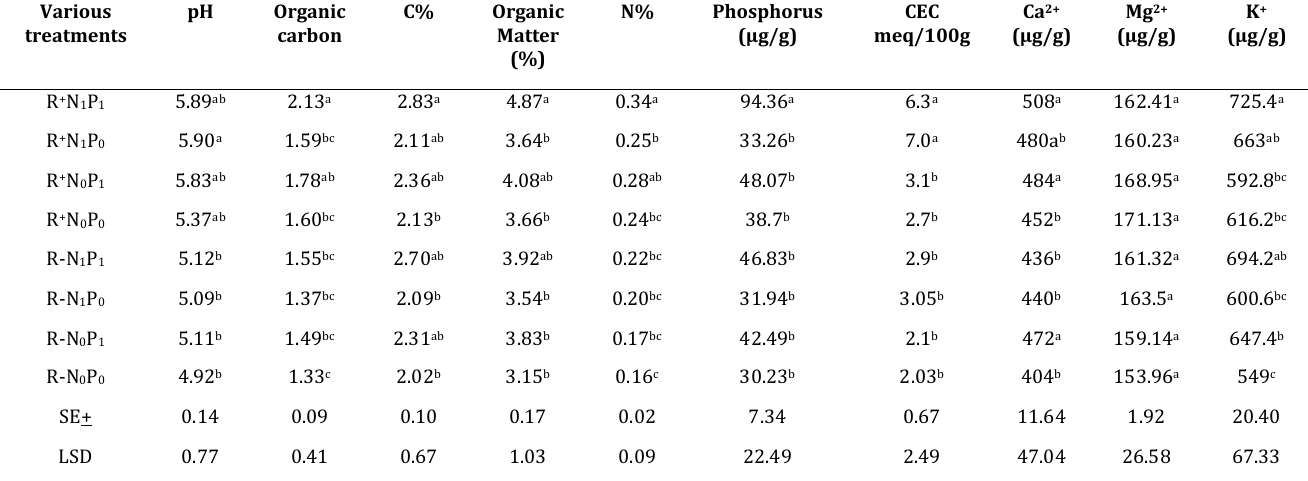
Table 2: Effects of various treatments on Physico- chemical of soil